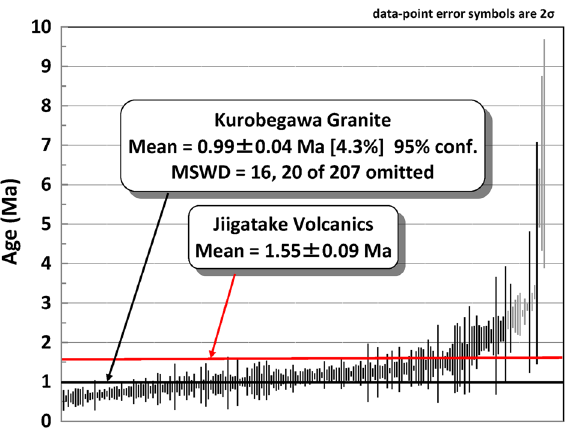
Figure 6. 238 U– 206 Pb age distributions for the Kurobegawa Granite (including ~ 2 Ma portion) zircons younger than 10 Ma (7 grains > 10 Ma are omitted). Individual grain ages with 2σ uncertainty are arranged in rank order. Analyses in grey represent statistical outliers and were excluded. Black and red horizontal bars represent mean U–Pb age of the Kurobegawa Granite and the ~ 1.55 Ma Jiigatake eruption, respectively. MSWD mean square weighted deviation.